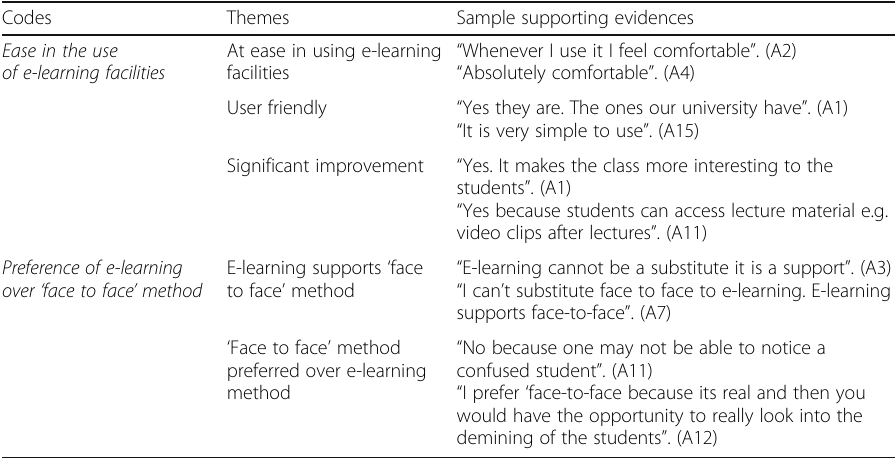
Table 8 Preference and ease of e-learning adoption over ‘ face to face ’